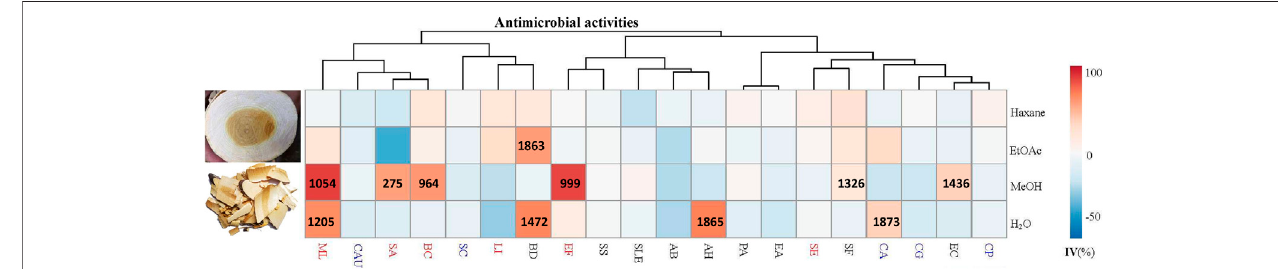
FIGURE 1 | Antimicrobial activities (IC 50 ) ( μ g/ml) of different solvent extracts of Picrasma quassioides stem; IV: inhibition value; The abbreviations are the initials of thescienti fi cnamesofthetestedmicroorganism,including fi vefungi[ Candidaalbicans (CA), Candidaparapsilosis (CP), Candidaauris (CAU), Candidaglabrata (CG),and Saccharomyces cerevisiae (SC)], nine G – bacteria [ Escherichia coli (EC), Pseudomonas aeruginosa (PA), Shigella sonnei (SS), Acinetobacter baumannii (AB), Enterobacteraerogenes (EA), Brevundimonasdiminuta (BD), Shigella fl exneri (SF), Salmonellaenterica subsp.enterica(SLE),and Aeromonashydrophila (AH)],and six G + bacteria [ Staphylococcus aureus (SA), Staphylococcus epidermidis (SE), Micrococcus luteus (ML), Listeria innocua (LI), Enterococcus faecalis (EF), and Bacillus cereus (BC)], marked in blue, black, and red, respectively.